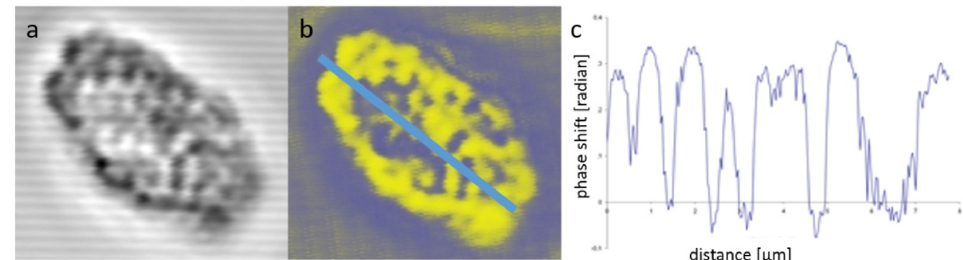
Figure 4. Non-confocal transmission ( a ) and LB ( b ) images of an isolated, edge-aligned TM system of a granal (pea) chloroplast; and variations of the phase shift (LB) ( c ) along the axis of the TM system. (Composed from parts of a figure published in [40], with permission from Springer